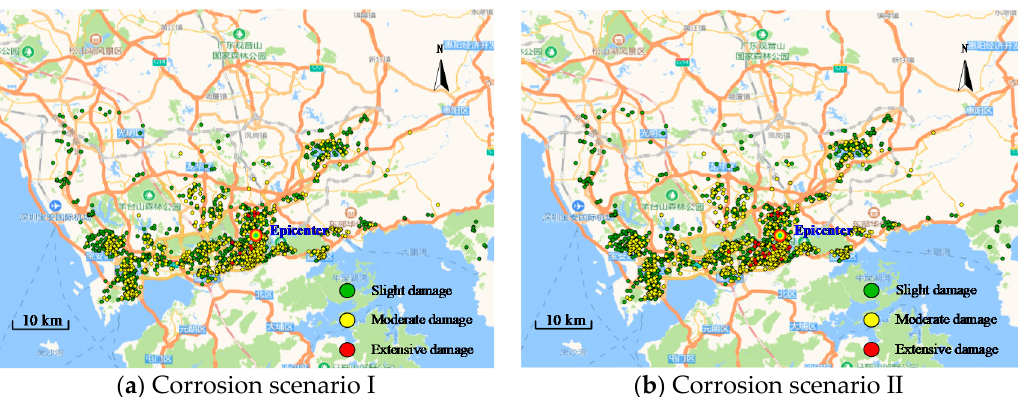
Figure 17. Distributions of building seismic damage results (M6.5): ( a ) Corrosion scenario I; ( b ) Corrosion scenario II